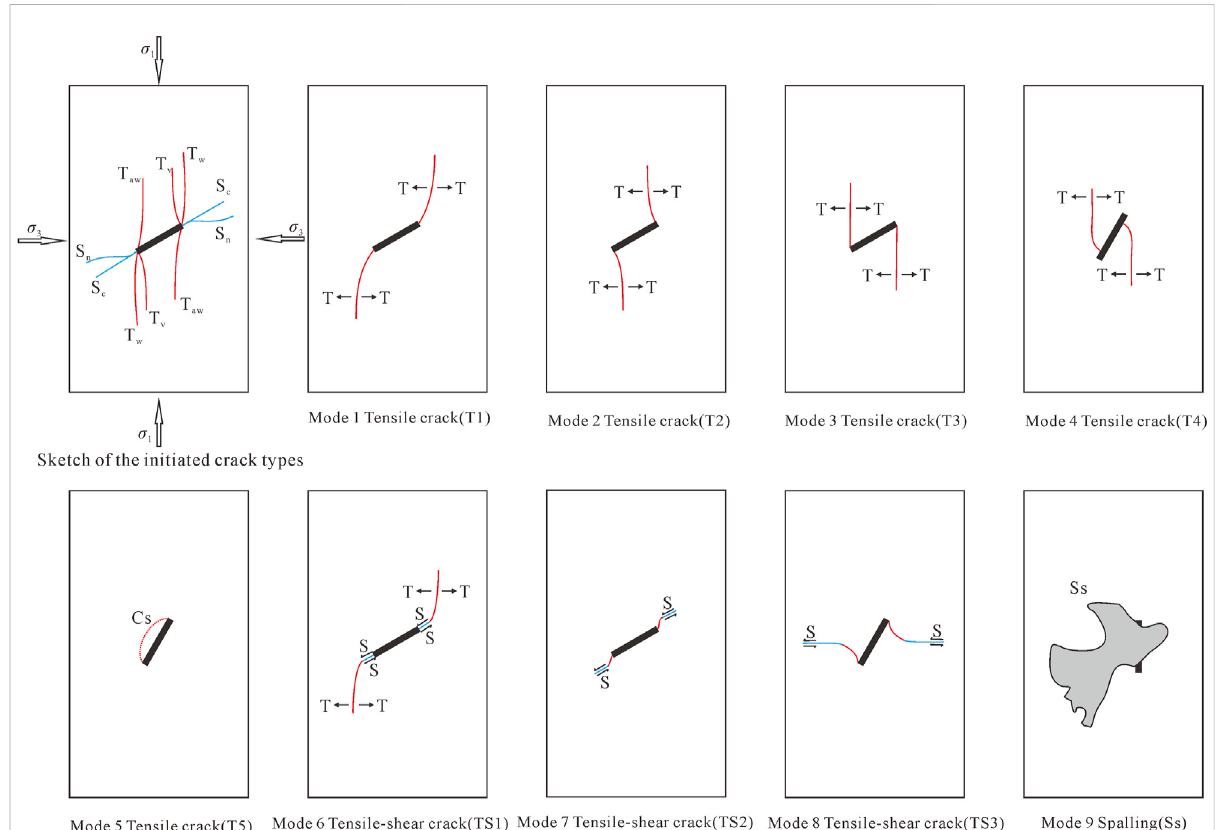
FIGURE 3 Crack types initiated from a single fl aw under triaxial loading. (T Tensile crack, S Shear crack, Cs enveloping cracks, and Ss Surface